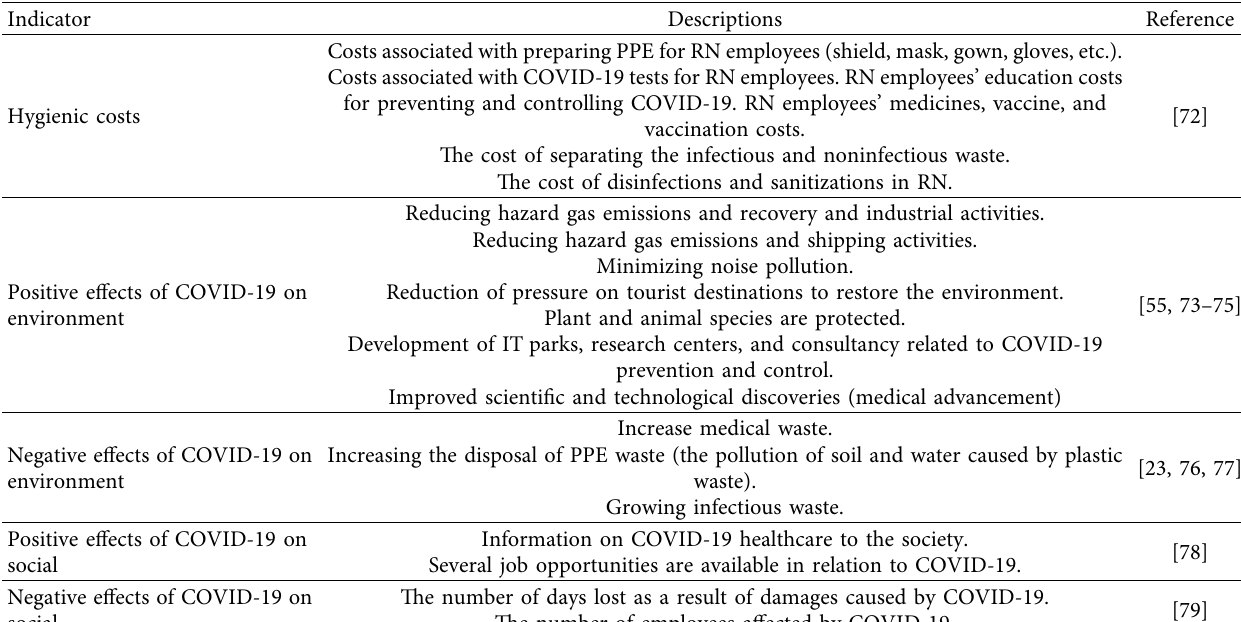
Figure 3: Effects of COVID-19 virus on RN. Table 2: The indicators of sustainability for SRN during the